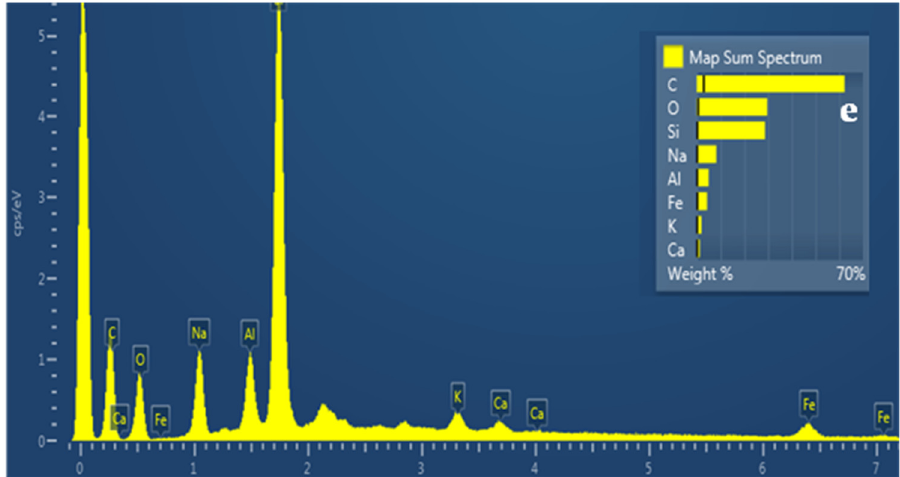
Figure 8. ( a , c ) SEM images of surface and ( b , d ) cross-section for the nanocomposite films of ALG/G/10NZ ( a , b ) and ( c , d ) ALG/G/10TO@NZ ( c , d ) respectively. ( e ) Energy dispersive spectrome- ter (EDS) spectrum and relative elemental analysis of the surface (inset) from the SEM image ( a ).